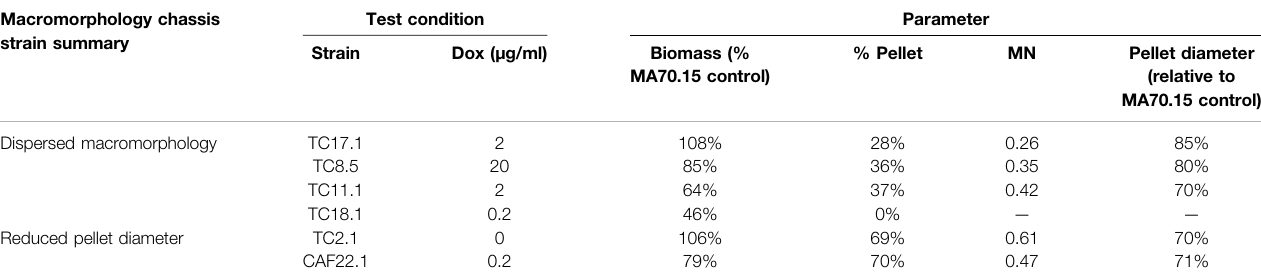
TABLE 2 | Exemplar macromorphological chassis options available from the morphogene library. Various options for dispersed morphologies, biomass, MN, and diameter are given. Macromorphology chassis strain